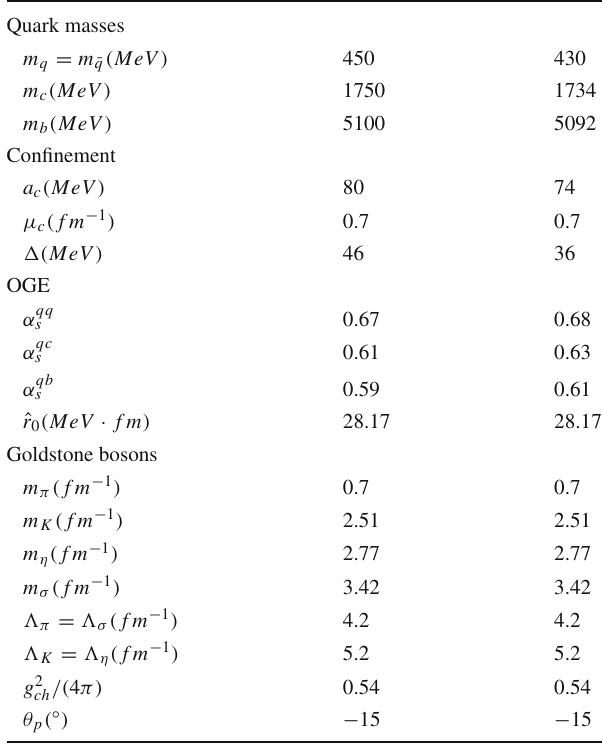
Table 1 Quark Model